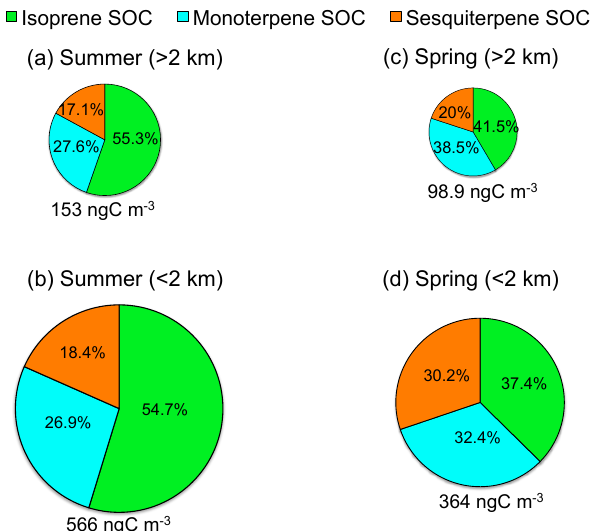
Fig. 11. Averaged concentrations of secondary organic carbon (SOC) and the relative abundances of SOA from the oxidation of isoprene, monoterpene and sesquiterpene in the aerosol samples collected at relatively high (>2km) and low (<2km) altitudes in both seasons. SOC values are estimated using a tracer-based method by Kleindienst et al. (2007). The sizes of the pie charts are propor- tional to the averaged total SOC concentrations for each